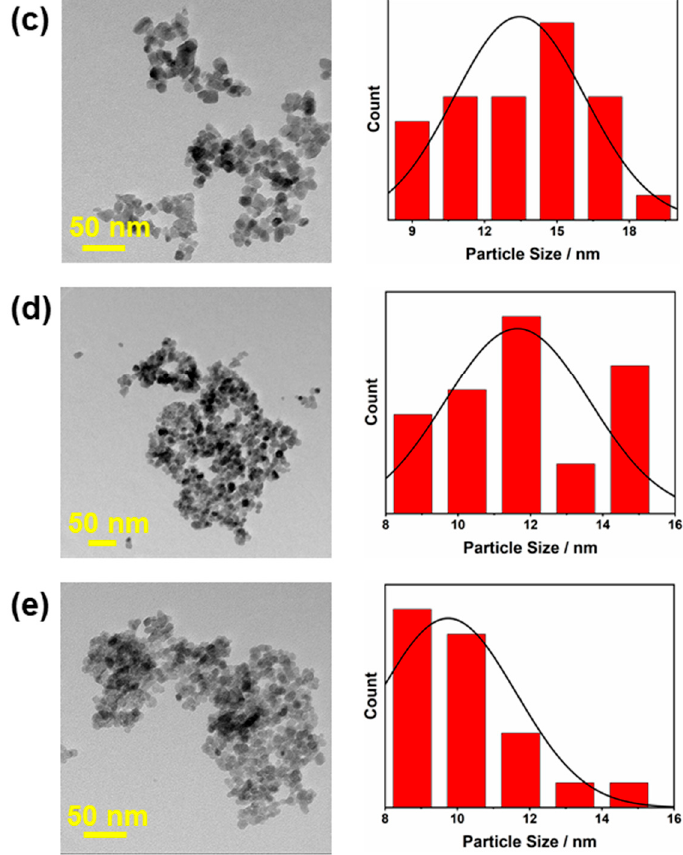
Figure 1. TEM micrographs and the corresponding particle size distribution of ( a ) TiO 2 , ( b ) TiO 2 -Mo-0.9, ( c ) TiO 2 -Mo-1.5, ( d ) TiO 2 -Mo-2.2, and ( e ) TiO 2 -Mo-3.1.